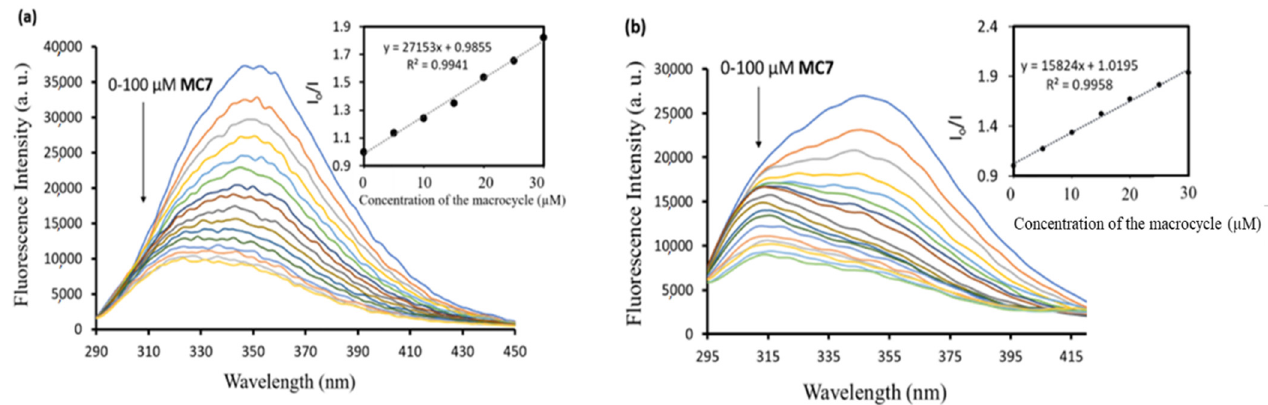
Figure 4. Fluorescence quenching of protein by MC7 at excitation wavelength 280 nm, ( a ) BSA and ( b ) HSA. To 10 µ M protein solution in phosphate buffer (pH 7.4), 2–100 µ M macrocycle solution was added at 25 ◦ C. Inset: Stern–Volmer Plot; I o and I are the fluorescence intensity at 0 µ M and the given concentration of the macrocycle, and the slope is considered as the binding constant.